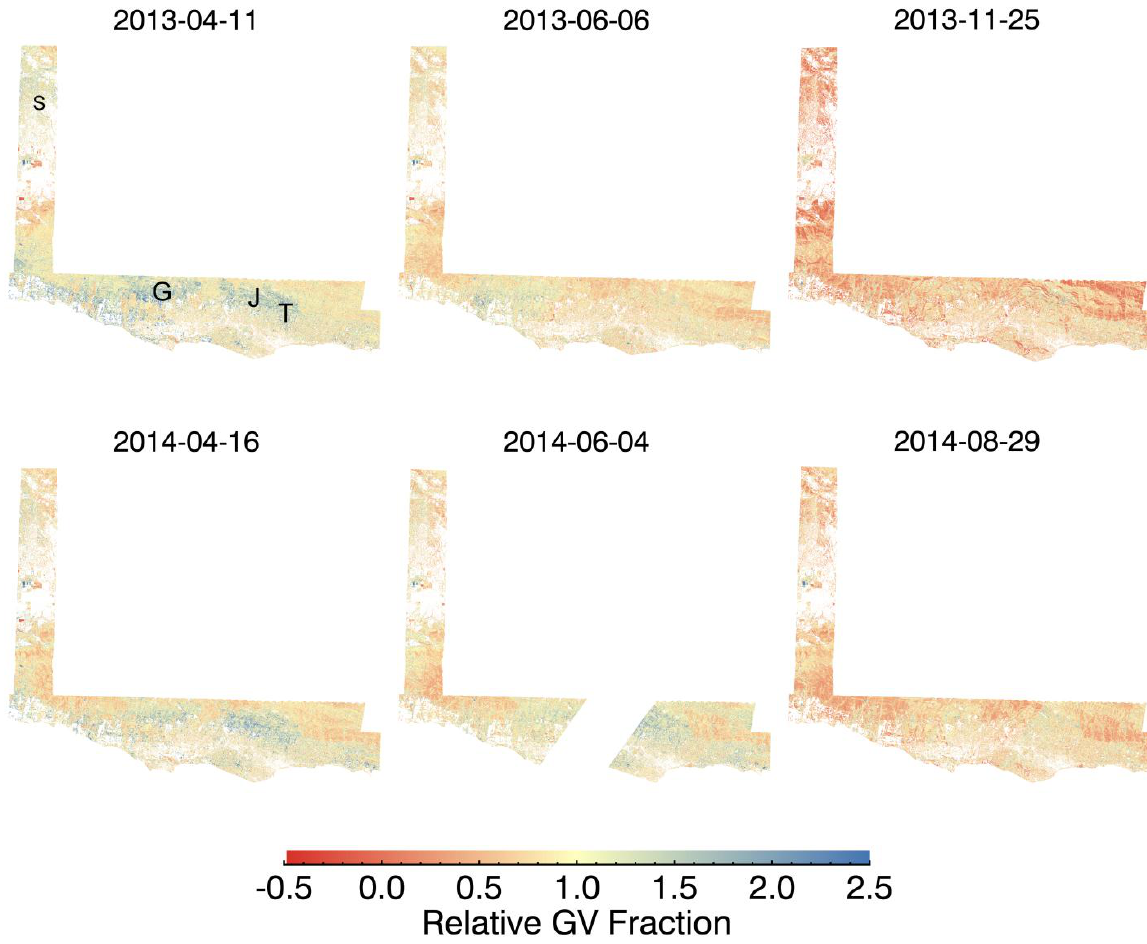
Figure 4. Relative GV fraction for dates in 2013 and 2014. White areas indicate pixels with an NDVI less than 0.3 in the July 2011 data. An instrument malfunction resulted in missing data for the white strip shown in the 2014-06-04 image. Fire scars for the Gap, Jesusita, and Tea fires are indicated by the letters G, J, and T, respectively. The location of the Sedgwick Ranch station recording precipitation and soil moisture data shown in Figure 2 is indicated by the letter